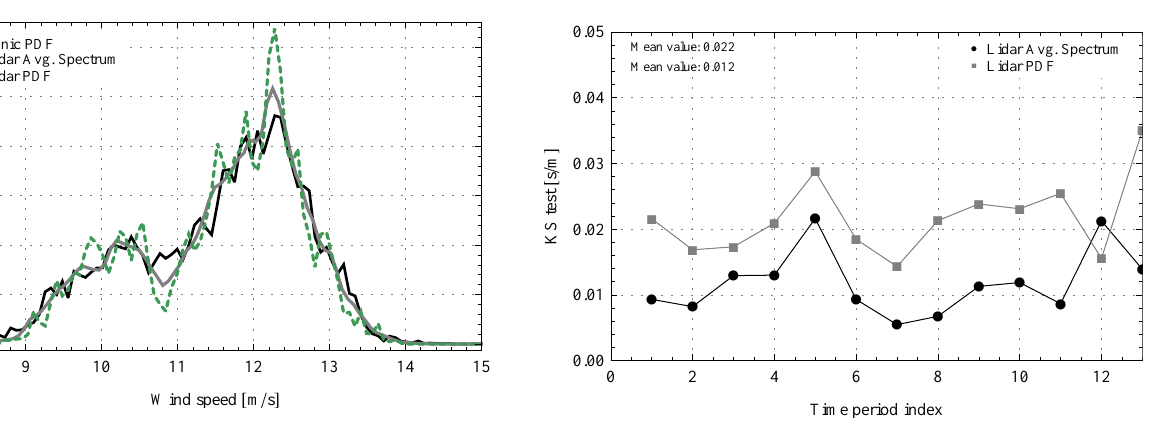
Fig. 3. Similar to Fig. 1, but for another 30min period. Sonic veloc- ities have been multiplied with 0 . 993 in order to compensate for the imperfect calibration shown in Fig. 2. The pdf from the lidar time series (Lidar PDF) has been added to the figure.